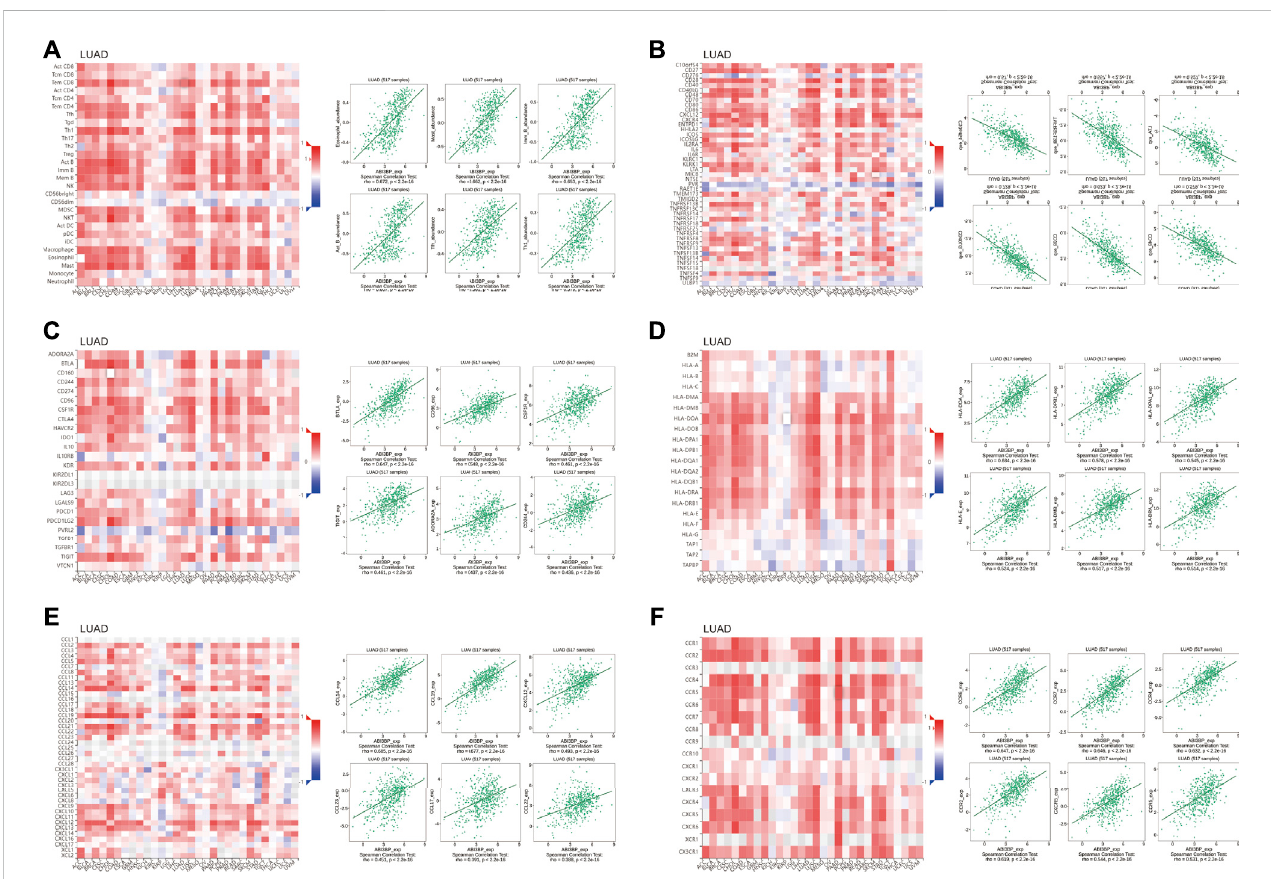
FIGURE 9 RelationofABI3BP levelofexpressionandlymphocytes,immunitymodulatorsandchemokinesinLUADonthebasisofTISIDBrepository. (A) Relationof tumor-in fi ltrating lymphocyte (TIL) abundance and ABI3BP (6 TIL with the greatest correlation); (B – D) Relation of immunomodulators and ABI3BP (the six immunomodulators with the greatest correlation); (E – F) Relation of chemokines (or receptors) and ABI3BP [6 chemokines (or receptors) with the greatest correlation